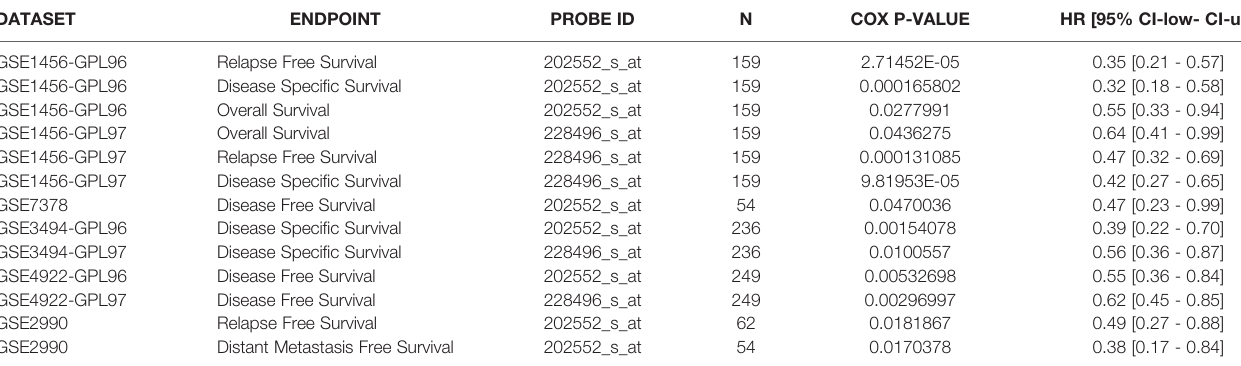
TABLE 4 | CRIM1 expression and survival data of breast cancer patients through the PrognoScan database.